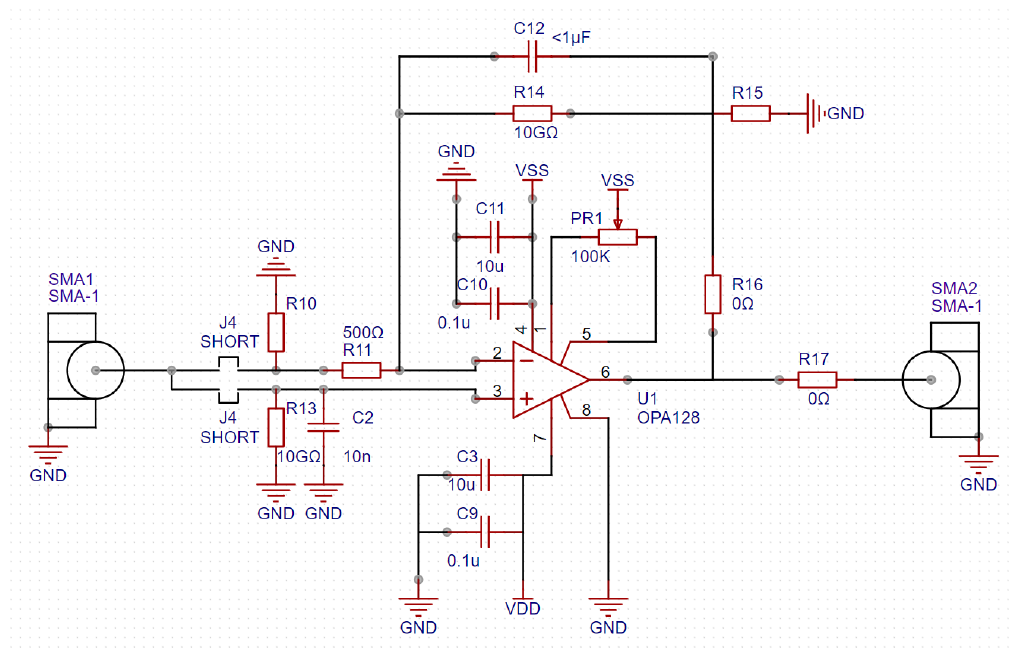
Figure 6. Circuit diagram of charge-amplifying and conversion.